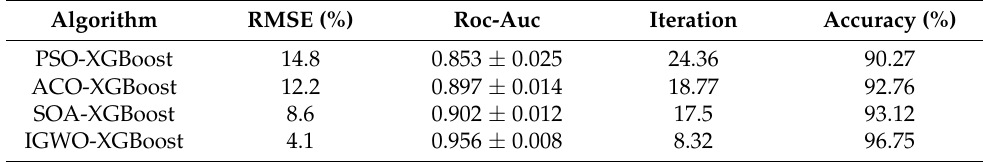
Table 2. Results of MC recognition of four